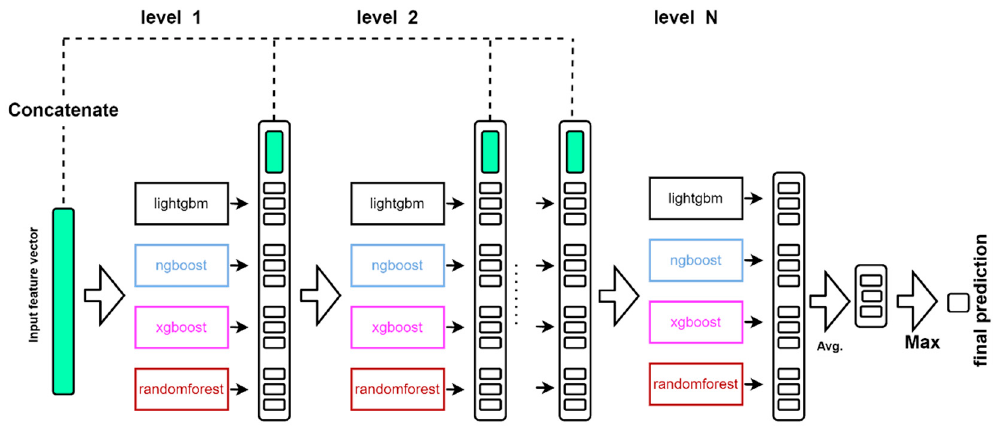
Figure 6. Diagrammatic representation of the cascade forest structure.